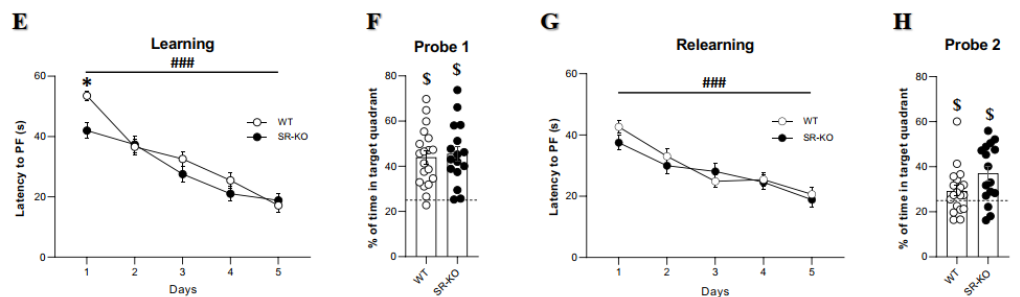
Figure 2. SR deletion does not impair spatial learning, reference memory, and cognitive flexibility in the Morris water maze (MWM). ( A – D ). Swimming velocity during the learning, probe test 1, relearning and the probe test 2 in WT control and SR-KO mice (two-way ANOVA) ( E ). Latency to reach the platform (PF) during the spatial learning (### for p < 0.001 for two-way ANOVA repeated measures). The latency was lower during the first day of learning in SR-KO mice compared to WT mice but not on the other days (* p < 0.05 with two-way ANOVA). ( F ). Percentage of time spent in the target quadrant during the probe test 1 in WT and SR-KO mice. The percentages were significantly above the chance value of 25% shown by the dotted line and no di ff erence between groups ($, p < 0.05 one-sample t -test vs. > 25, unpaired t -test with Welch’s correction). ( G ). Latency to reach the PF during the relearning in WT and SR-KO mice. Both groups displayed a significant decrease in latency to find the PF across the five days, and there was no di ff erence between SR-KO and WT mice for each day (### p < 0.001 for two-way ANOVA repeated measures). ( H ). Percentage of time spent in the new target quadrant during the probe 2 in WT and SR-KO. Both groups displayed a percentage significantly above the chance value of 25% shown by the dotted line ($ p < 0.05 one-sample t -test vs. > 25, unpaired t -test with Welch’s correction). A number of 19 WT mice and 16 SRKO mice were tested in every stage of the